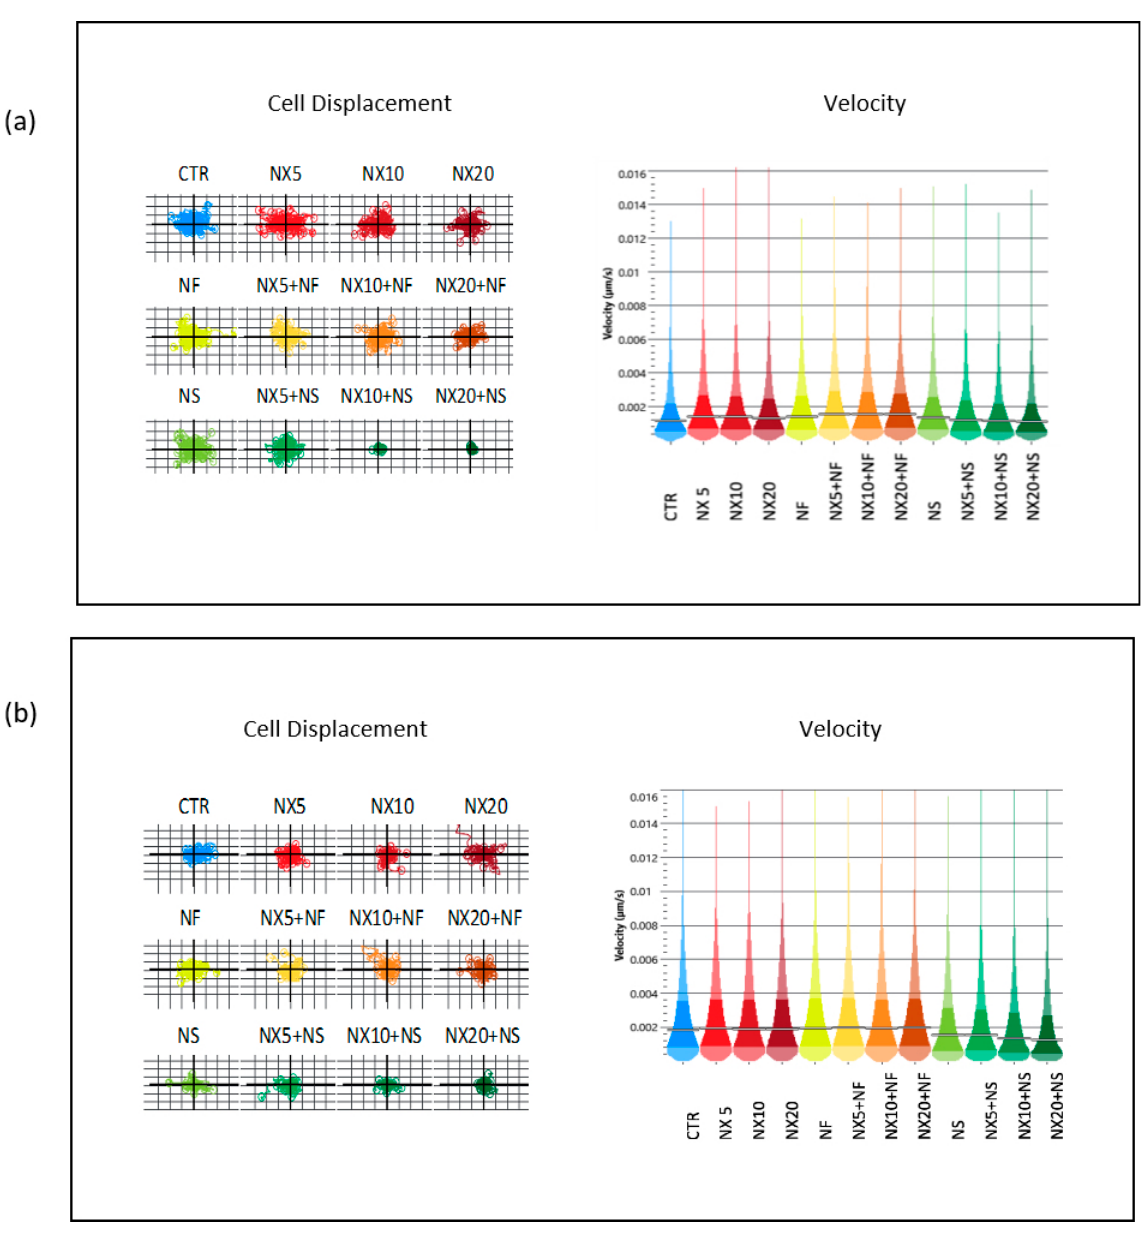
Figure 8 . Cell displacement and instantaneous velocity of ( a ) CHP-134 cells and ( b ) SH-SY5Y cells treated with NX at 5, 10, and 20 µg/mL, or NF, NS (0.05 mg/mL), NX in combination with NF, and treated with NX at 5, 10, and 20 µ g/mL, or NF, NS (0.05 mg/mL), NX in combination with NF, and NX in combination with NS. NX in combination with